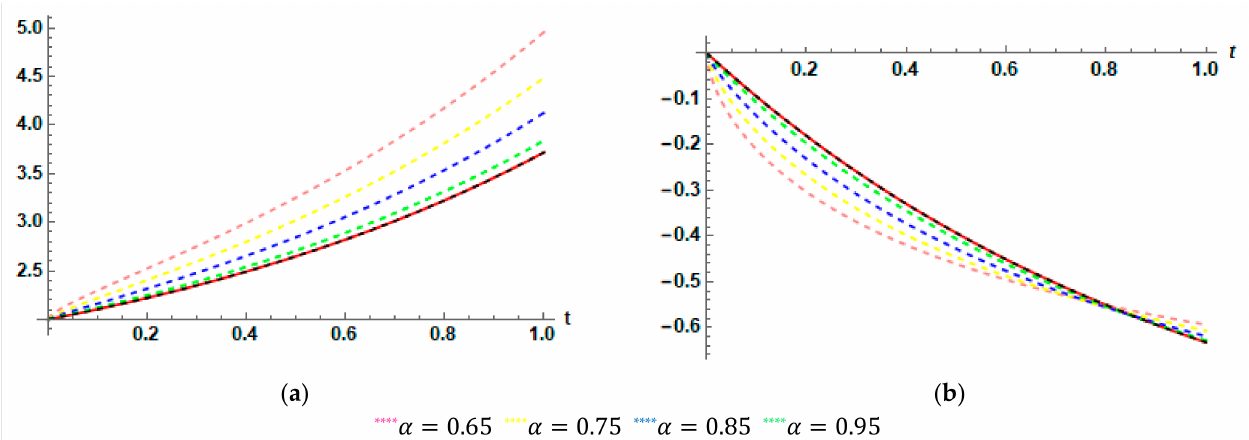
Figure 3. ( a ) Plot of exact solutions